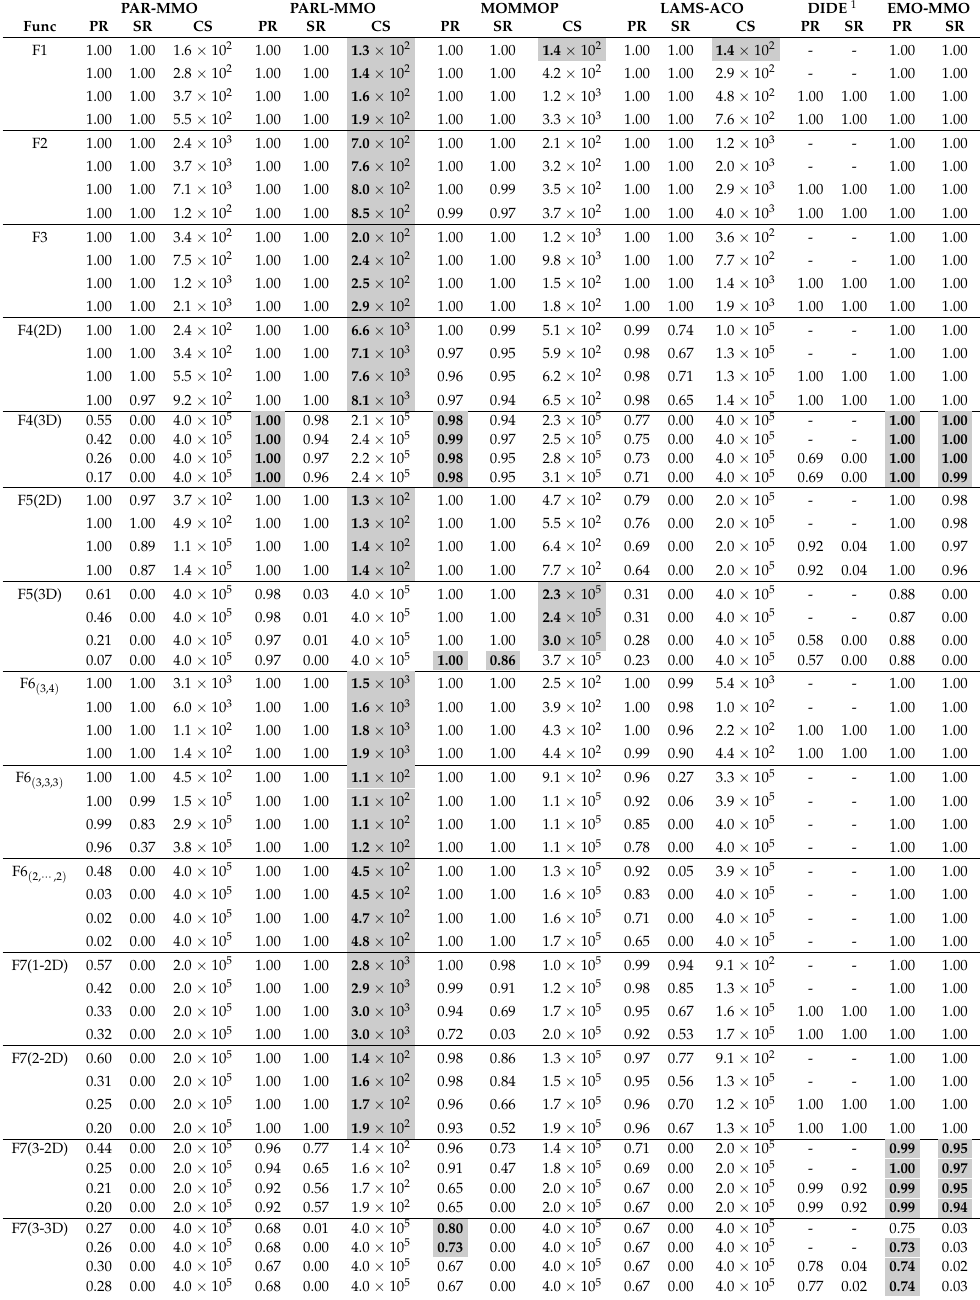
with dark background color (determined through the Wilcoxon rank sum test with p - value smaller than 0.0125 for the PR and p -value smaller than 0.0167 for the CS). All the experiments are repeated 100 times independently. It should be noticed that the EMO-MMO method uses all the available budget; thus, the CS column is not presented. Table 3. Comparisons (from top to bottom: ε = 1 × 10 − 1 , 1 × 10 − 2 , 1 × 10 − 3 , and 1 × 10 − 4 ). PAR-MMO PARL-MMO MOMMOP LAMS-ACO DIDE 1 EMO-MMO Func PR